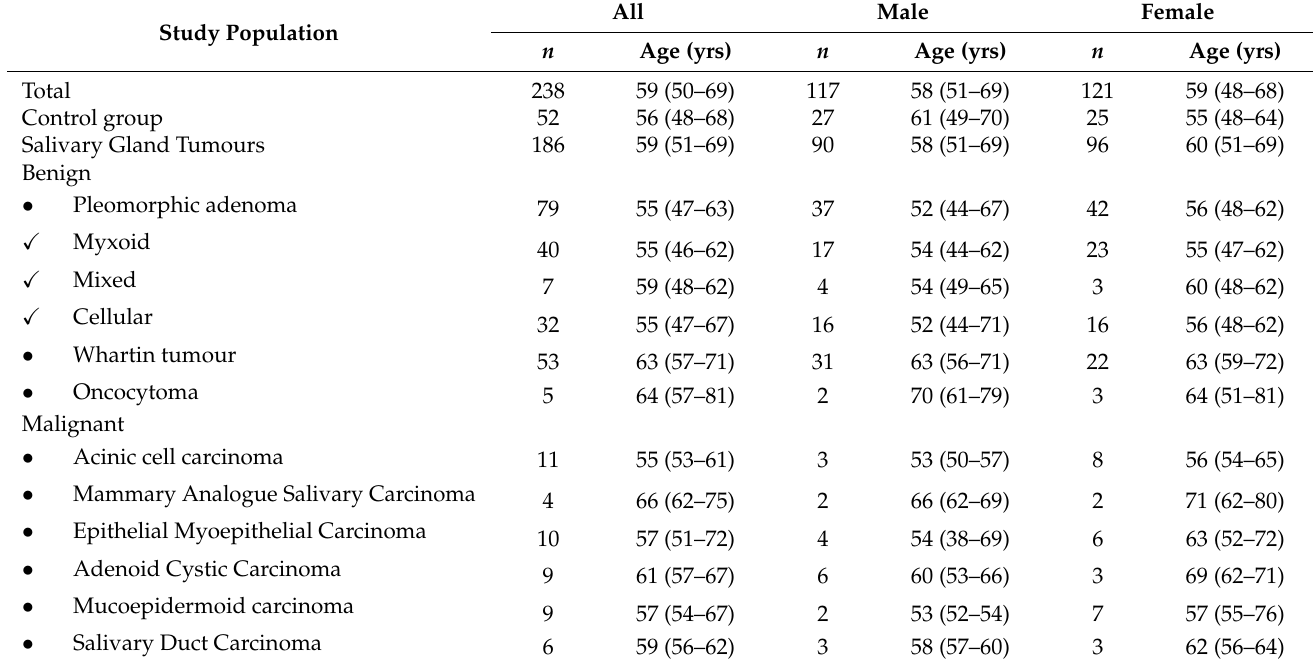
Table 1. Demographics characteristics of the study